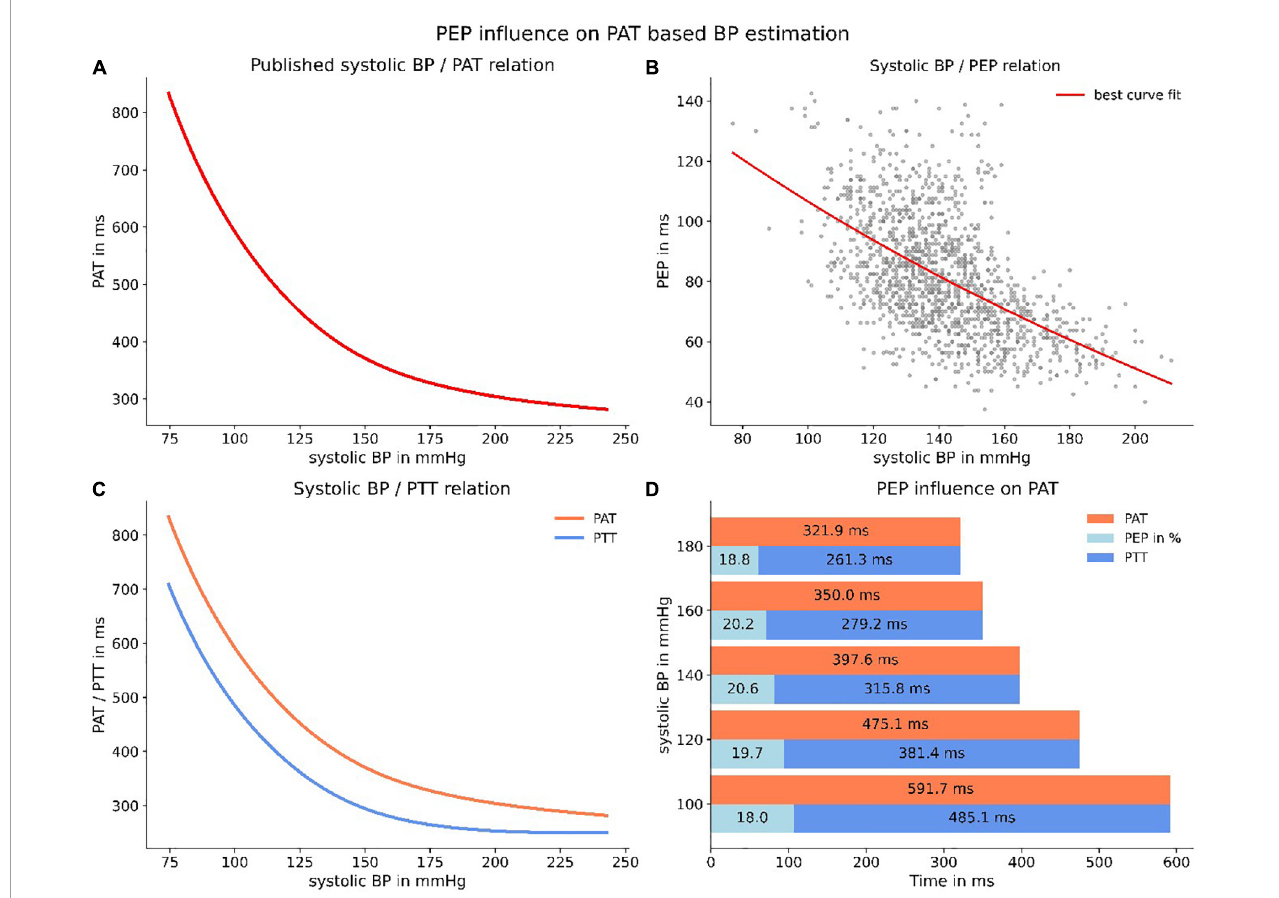
FIGURE9 Applying PEP to a published PWV-BP relation. Panel (A) depicts the relation, transformed to a PAT/BP relation for a “standard” human (1.80 m). Panel (B) represents the best polynomial fit for our data of PEP and SBP. Panel (C) depicts the resulting PTT-BP relation (PTT = PAT–PEP) when correcting PAT for PEP. The resulting line (blue) is the purest representation of a true PWV-BP relationship. Panel (D) highlights the (on average) constant proportion of PEP in